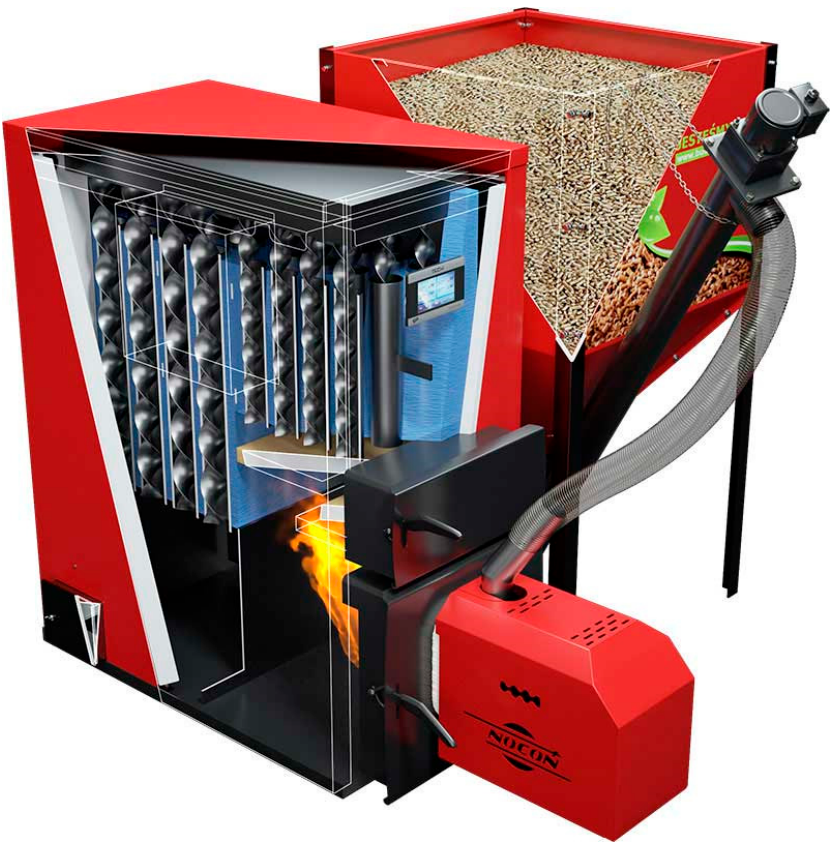
Figure 1 . Cross section of tested solid fuel boiler [28]. Figure 1. Cross section of tested solid fuel boiler